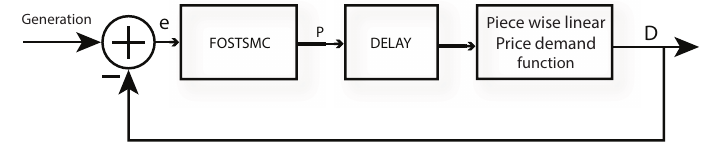
Figure 3. Block diagram for simulation of our proposed framework.